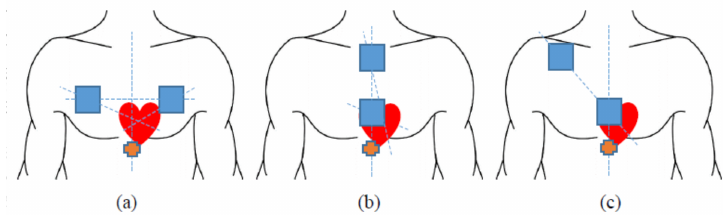
Figure 3. Sensor placements. ( a ) on the same horizontal level. ( b ) on the same vertical line. ( c ) on the diagonal line.